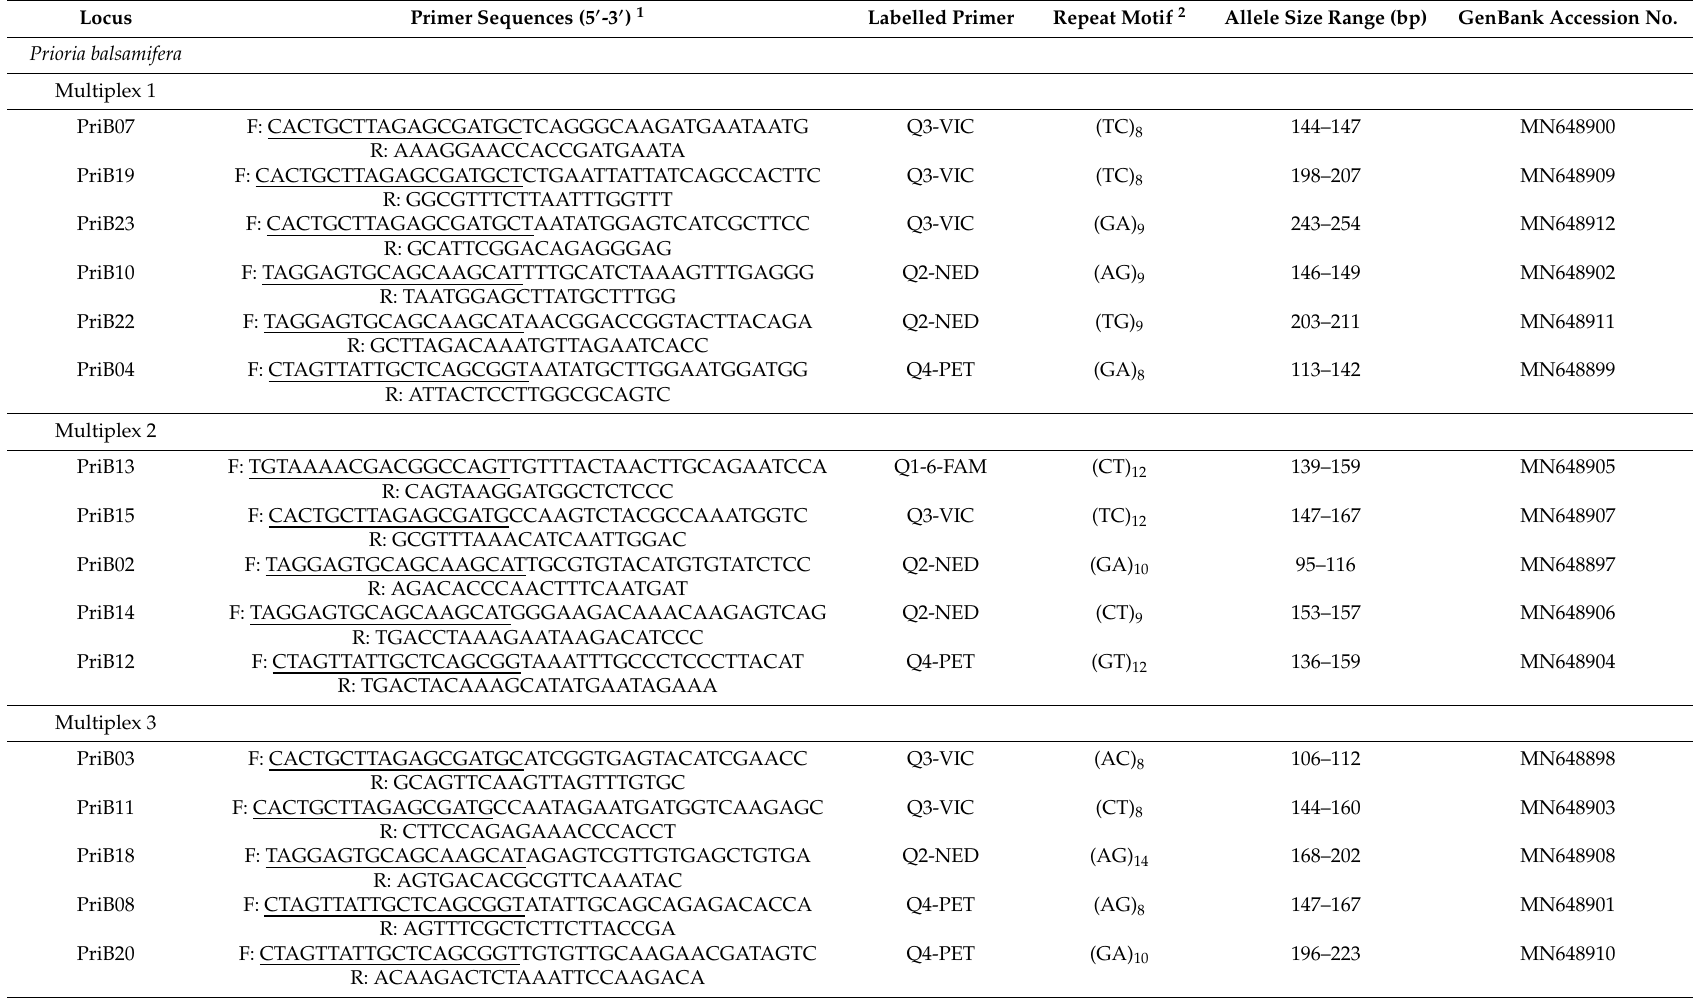
Table 1. Characterization of polymorphic microsatellite markers isolated from Prioria balsamifera (16 loci) and Prioria oxyphylla (15 loci).